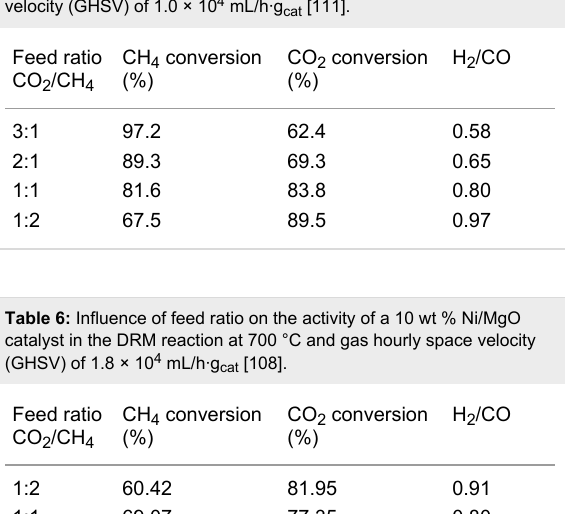
Table 5: Influence of feed ratio on the catalytic performance of 5 wt % Ni/MgO catalysts in DRM reaction at 700 °C and gas hourly space